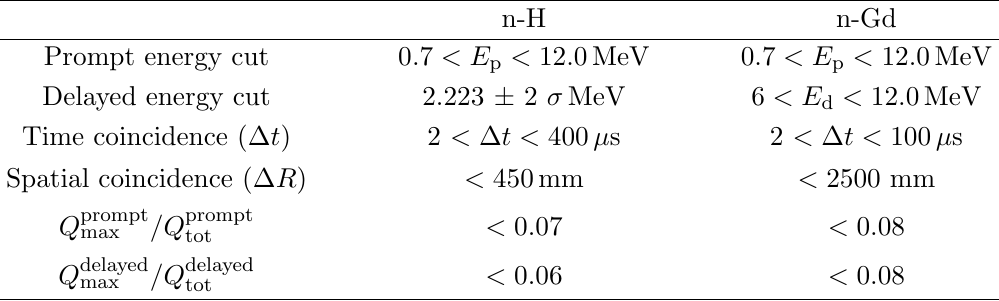
Table 2 . Comparison of IBD selection criteria for the n-H and n-Gd analysis.